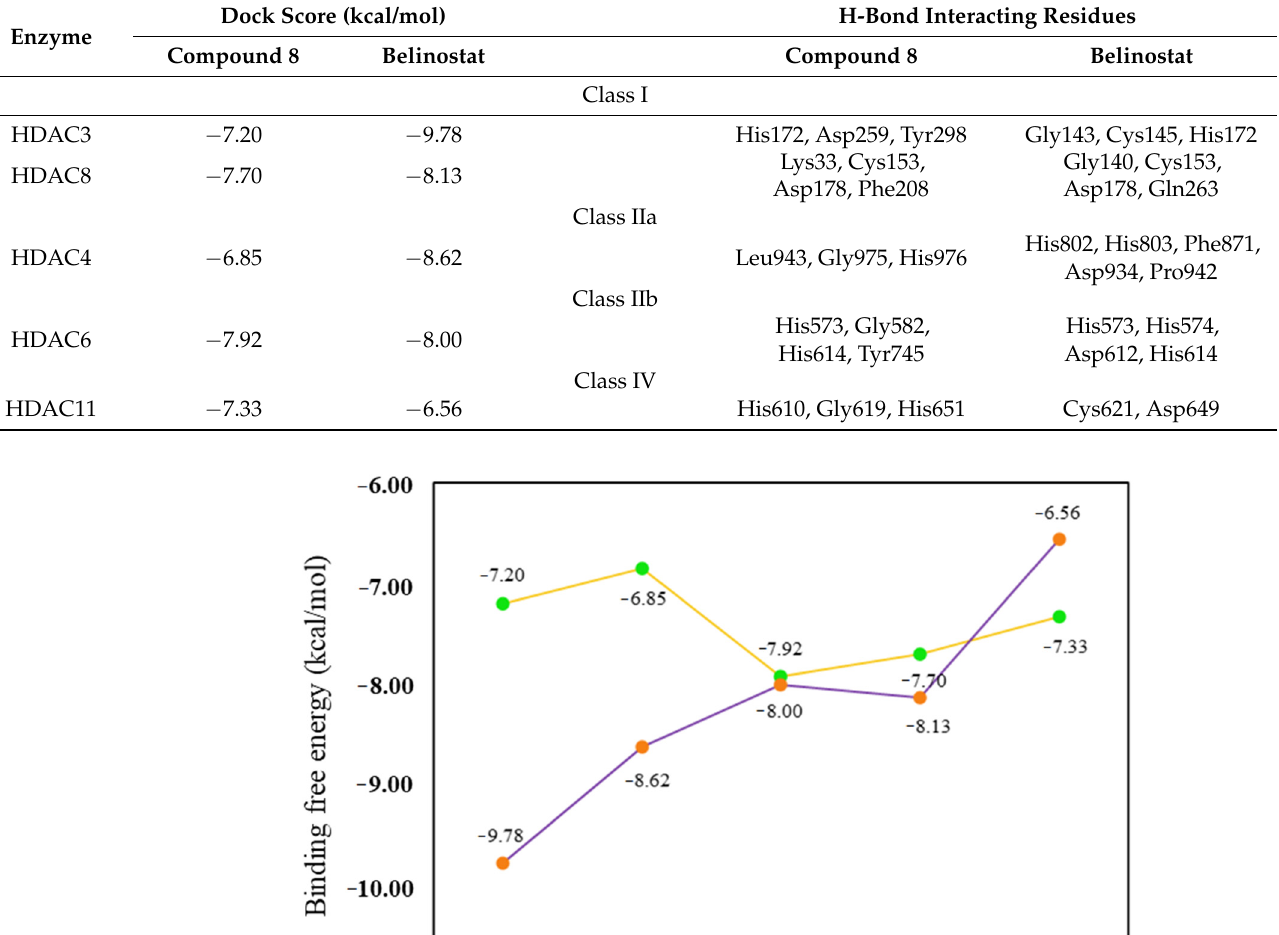
Figure 5. ( A ) Swiss-Model of HDAC11; ( B ) Ramachandran plot analysis of the structure of HDAC11